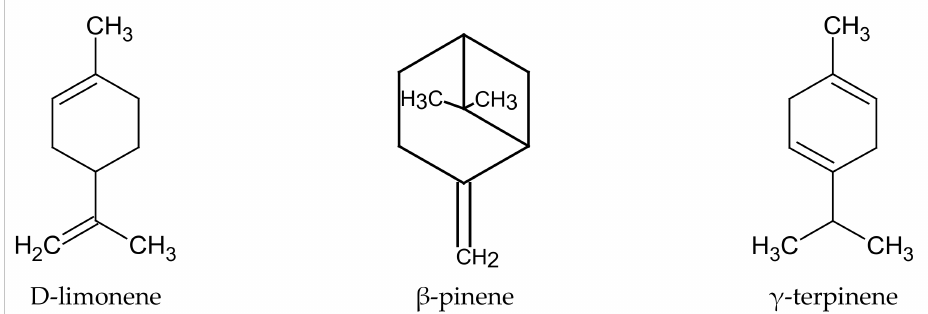
Figure 4. Chemical structure of selected terpenoids characteristic of C. limon essential